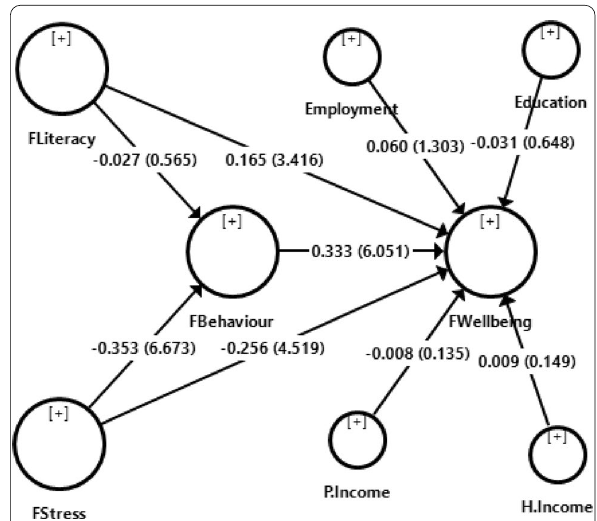
Fig. 3 PLS-SEM results of hypotheses testing using 5000